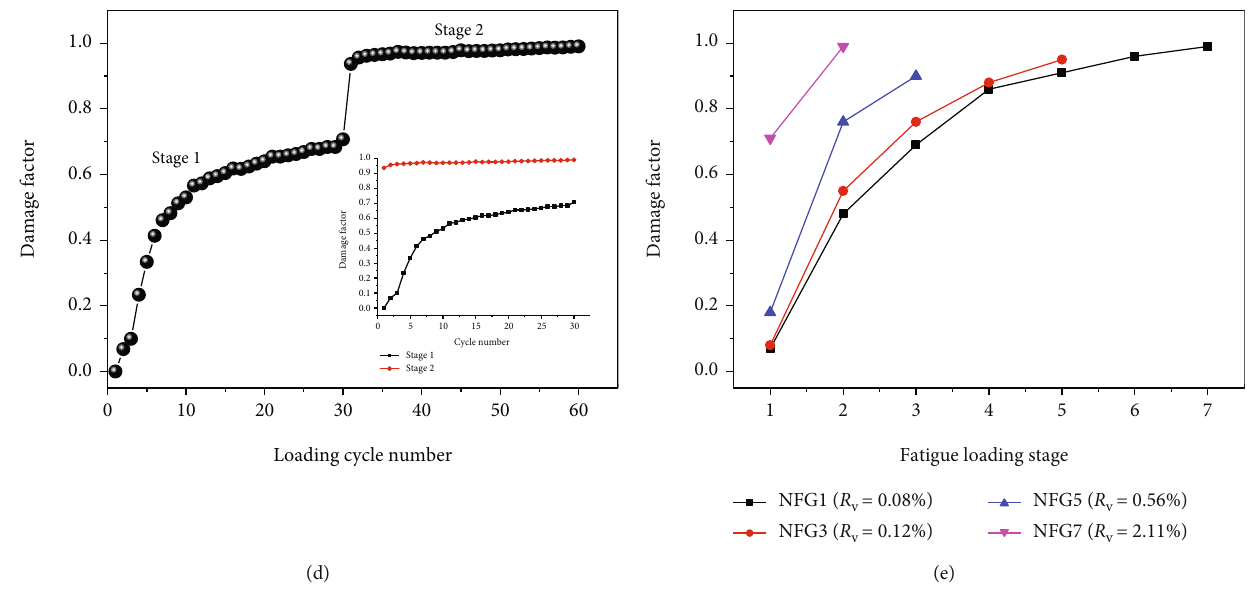
Figure 7: Plots of the damage evolution for the tested granite samples with di ff erent natural fracture volume